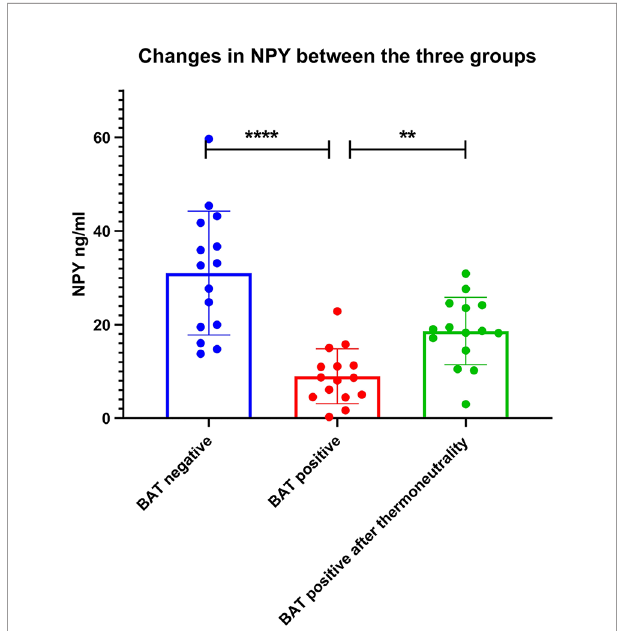
FIGURE 6 | Changes in NPY between the three groups. The NPY levels of 15 BAT positive subjects were lower than their negative controls ’ ( P < 0.001), which also increased after thermoneutrality ( P = 0.003). ** denotes P value < 0.01, **** denotes P value <